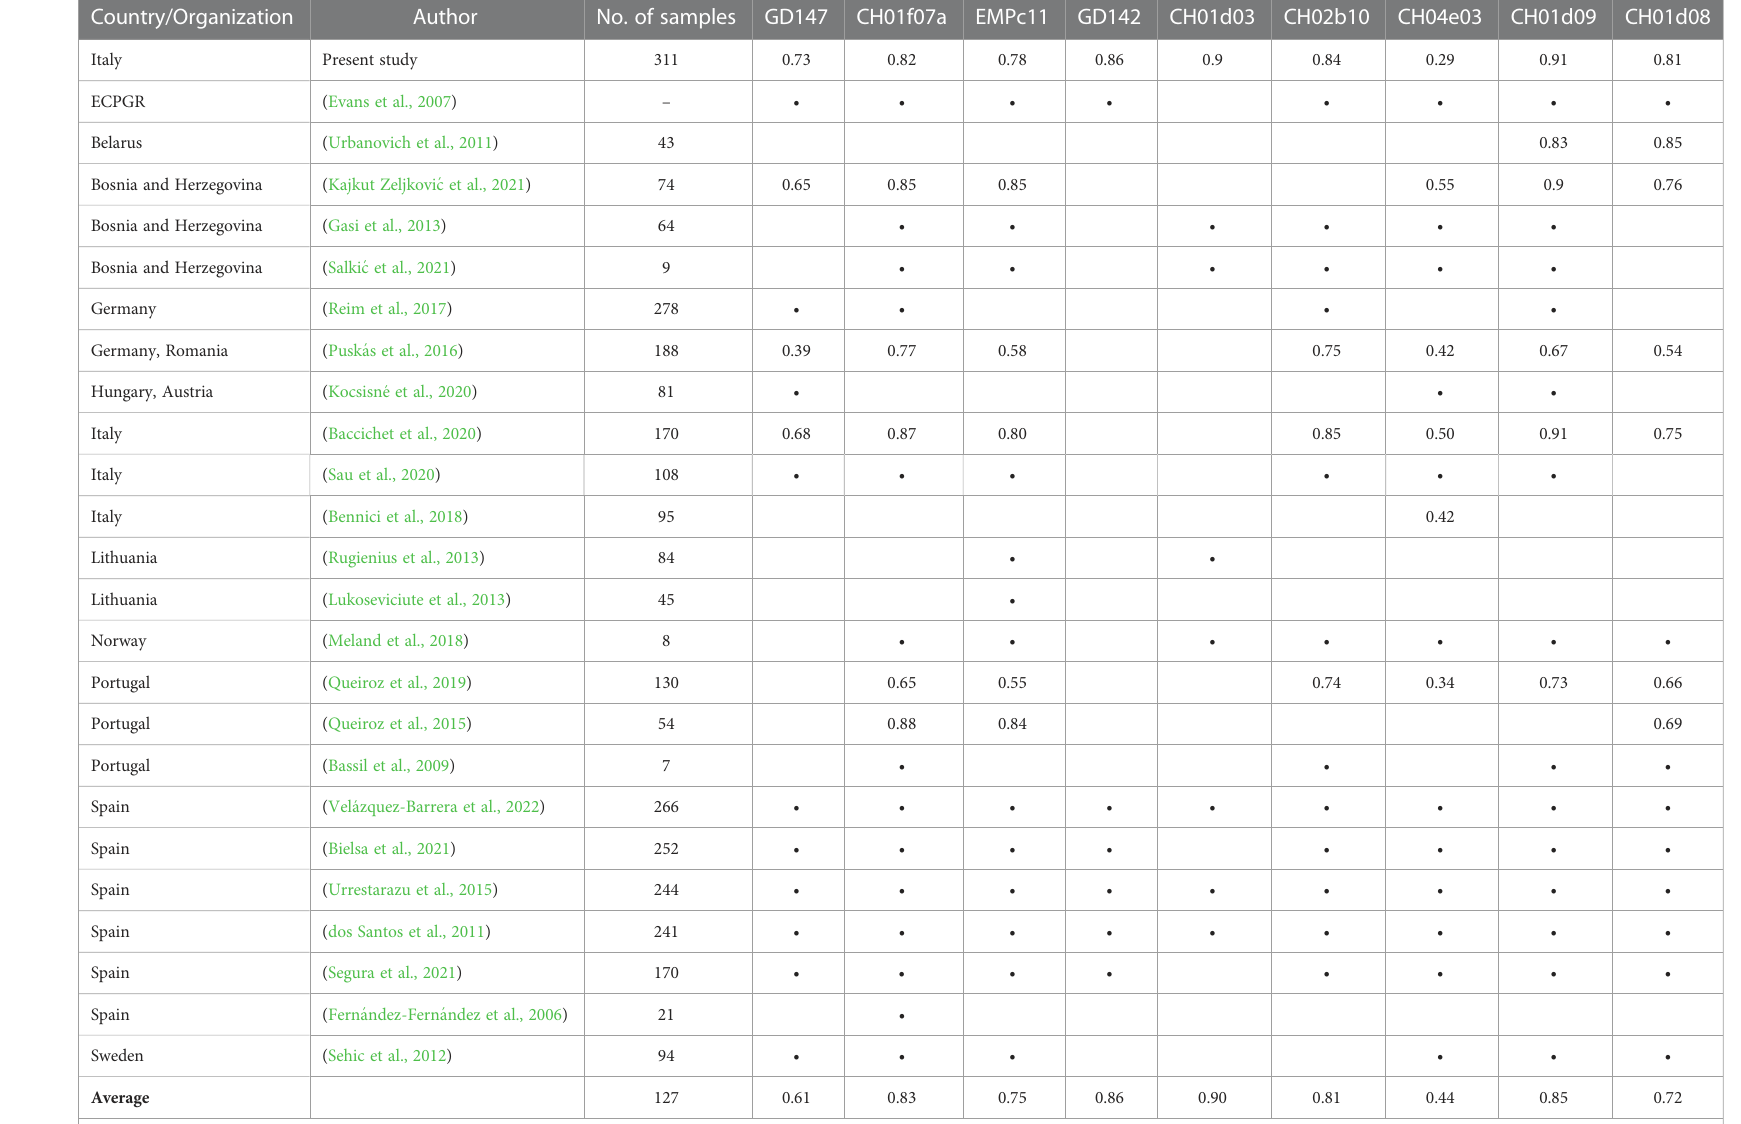
TABLE 3 Comparison of the research studies conducted in the last 20 years in Europe on Pyrus